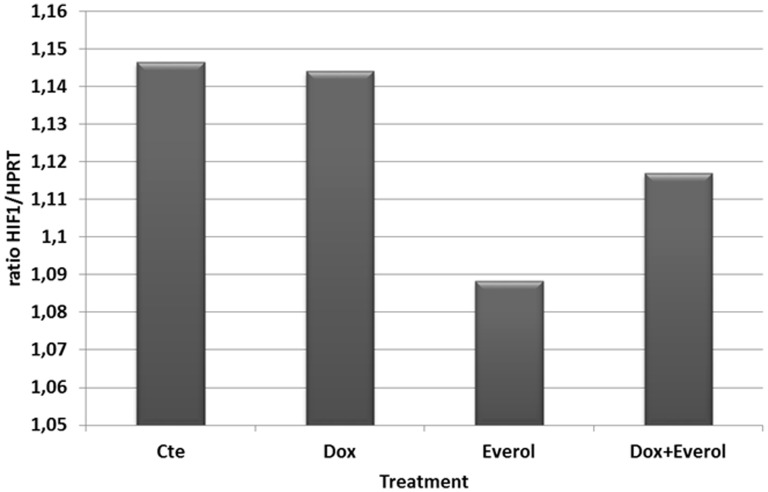
Everolimus did not affect the expression of the hypoxia key regulator HIF1α.RT-qPCR detection of HIF1α mRNA. HIF1α mRNA levels were expressed as a ratio of the corresponding HPRT mRNA level. Results indicate that everolimus induced a slight decrease (P = 0,05) in expression of HIF1α.